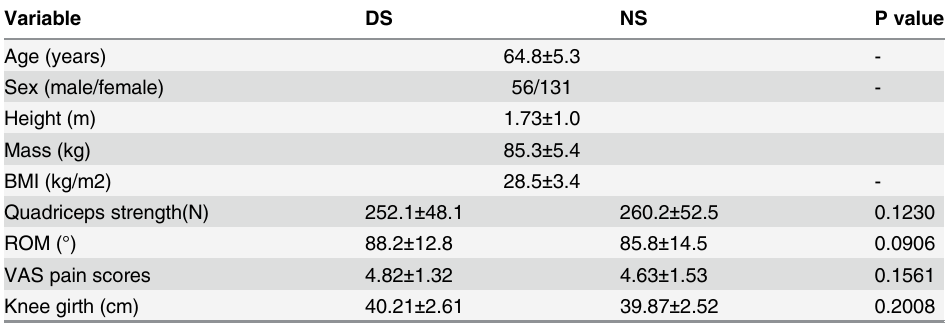
Table 1. Demographic characteristics and baseline